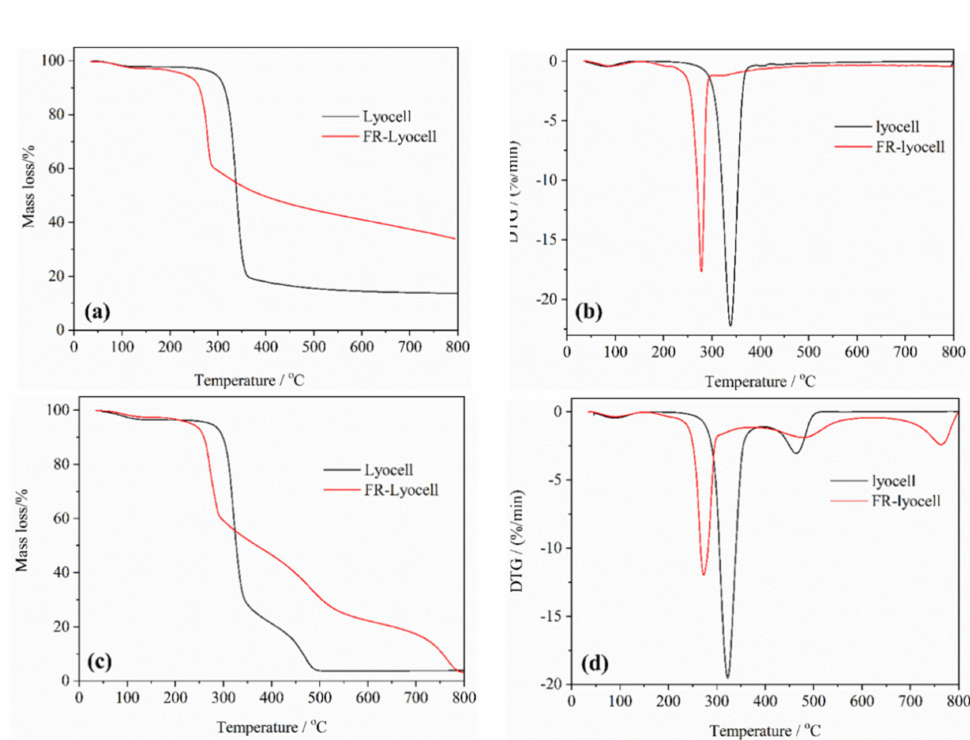
Figure 7. TG curves of lyocell and FR − lyocell fabrics in N 2 ( a ); DTG curves of lyocell and FR − lyocell fabrics in N 2 ( b ); TG curves of lyocell and FR − lyocell fabrics in Air ( c ); DTG curves of lyocell and FR − lyocell fabrics in Air ( d